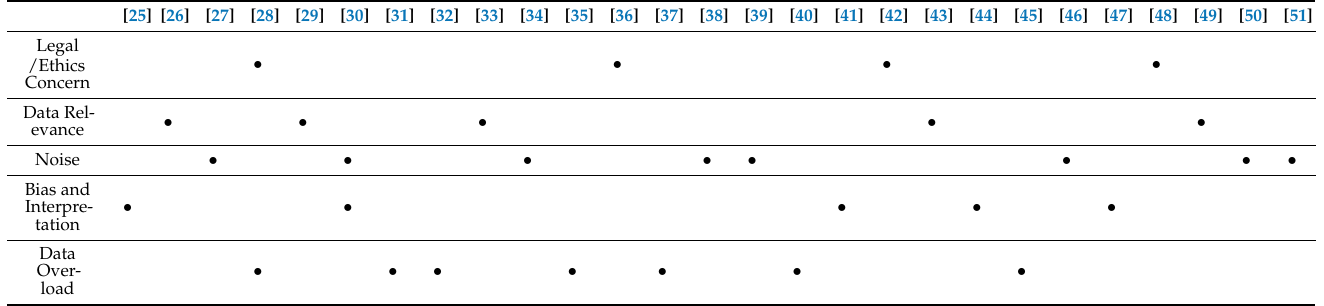
Table 2. Five critical challenges of social media-driven cyber